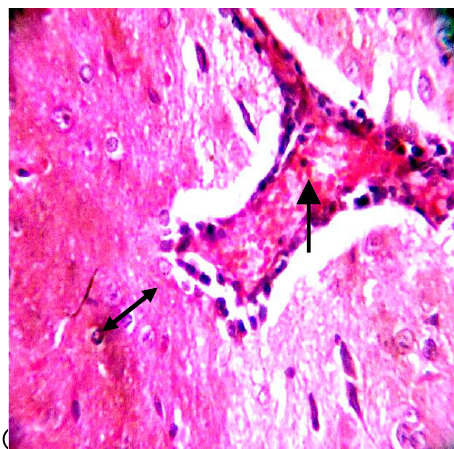
Fig: 7 Histopathological section in Brain of T1, show Fig:8, Histopathological section in Brain , T1, show per neuronal edema in granular layer (H&E stain. 40 X) center chromatolysis of neurons characterized by rounded or enlarged neurons. (H&E stain.40X)